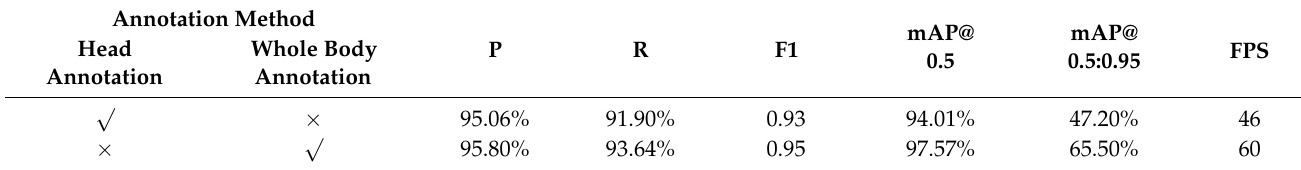
Table 4. Comparison of two different annotation experiments.